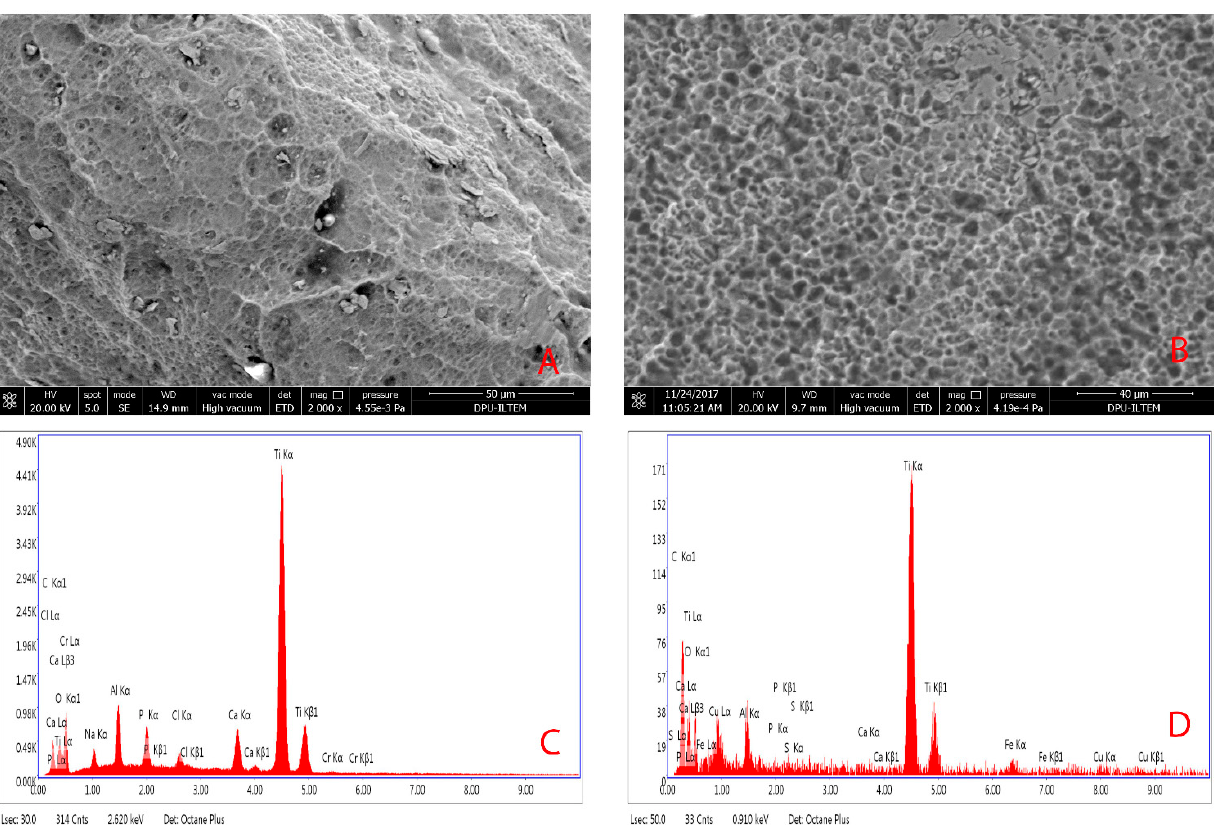
Figure 1. Scanning electron microscopy images of a failing dental implant: ( A ) Group I implant surface at × 2000 magnification; ( B ) Group II implant surface at ×2000 magnification; ( C ) EDX analysis diagram of Group I; ( D ) EDX analysis diagram of Group II.